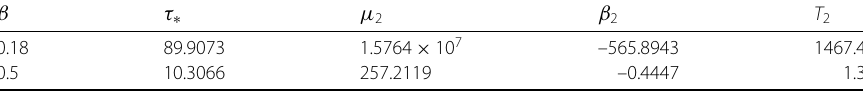
Table 2 Some parameters for model (1.4) with different ξ β τ ∗ μ 2 β 2 T 2 0.18 89.9073 1.5764 × 10 7 –565.8943 257.2119